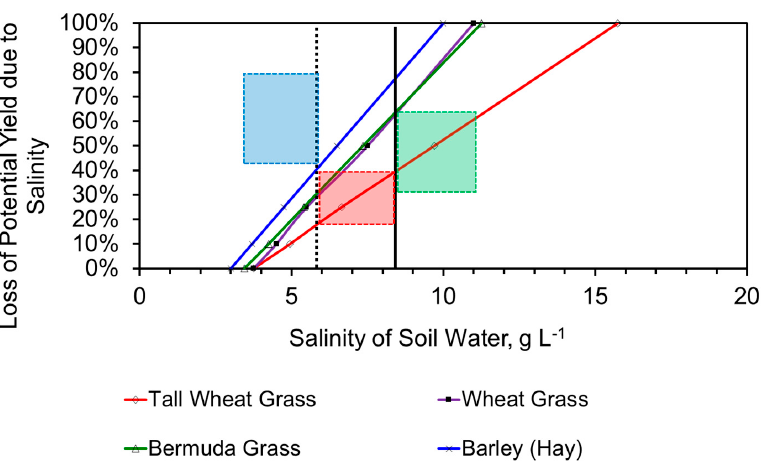
Figure 19. Tolerance of livestock to salinity—illustrative relationships. These vary with variety and region. Green = safe; blue = suitable; green = poor. Black line = average saline water salinity of 6.9 g L − 1 ; dashed black line = average partially desalinated water salinity of 4.77 g L − 1 (Table 1); orange arrow indicates the salinity removed by partial desalination (Table 1).